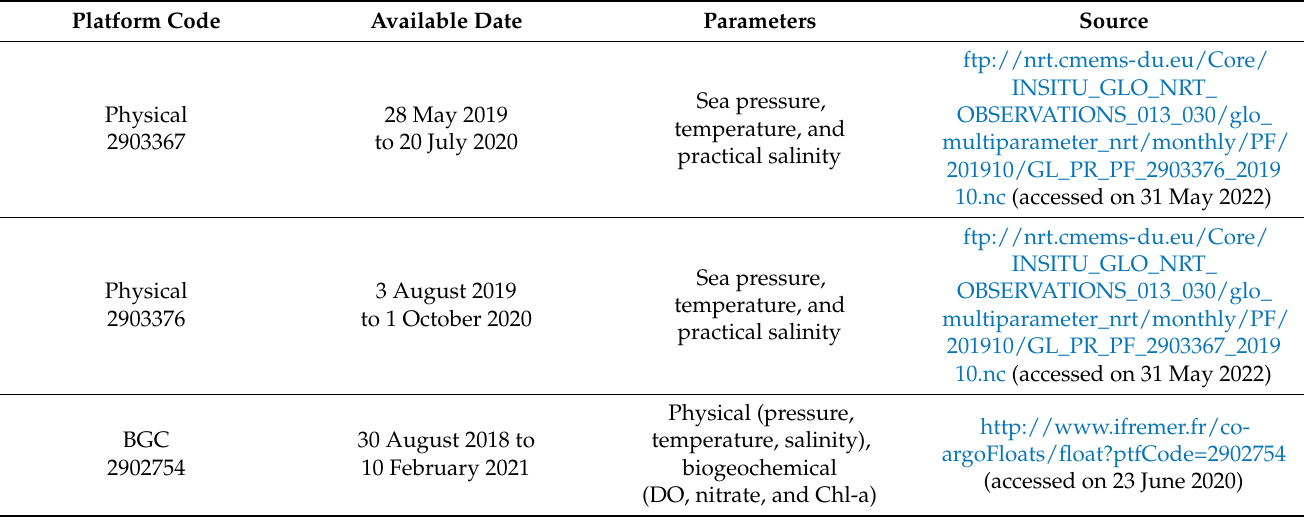
Table 1. Three Argo floats information used in this